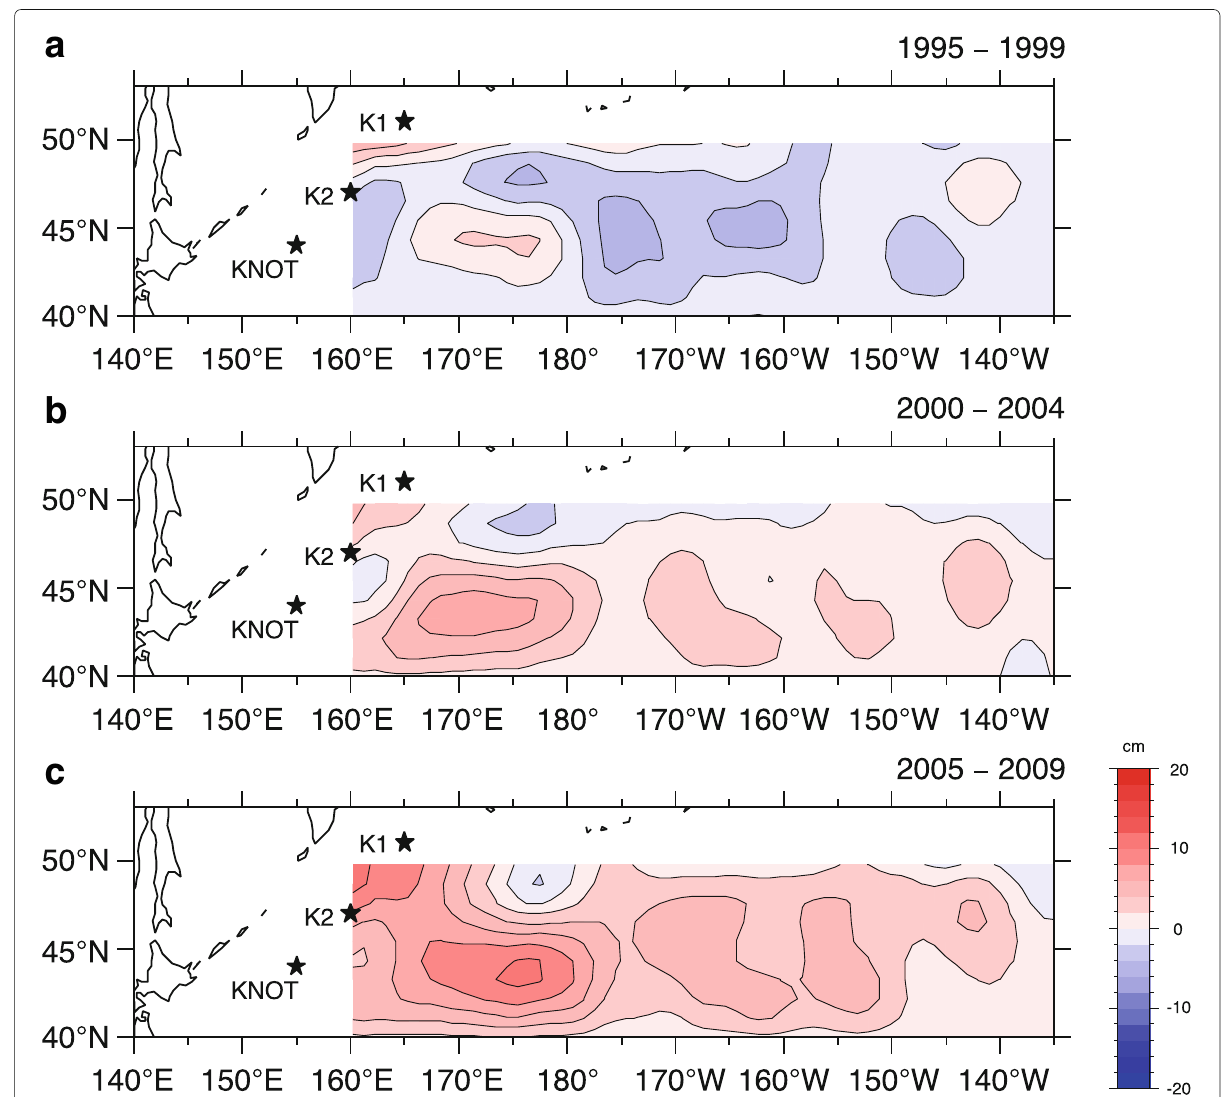
Fig. 13 Maps of wind-driven SSH averaged during a 1995–1999, b 2000–2004, and c 2005–2009. Contour interval is 2cm. Stars indicate locations of stations K1, K2, and